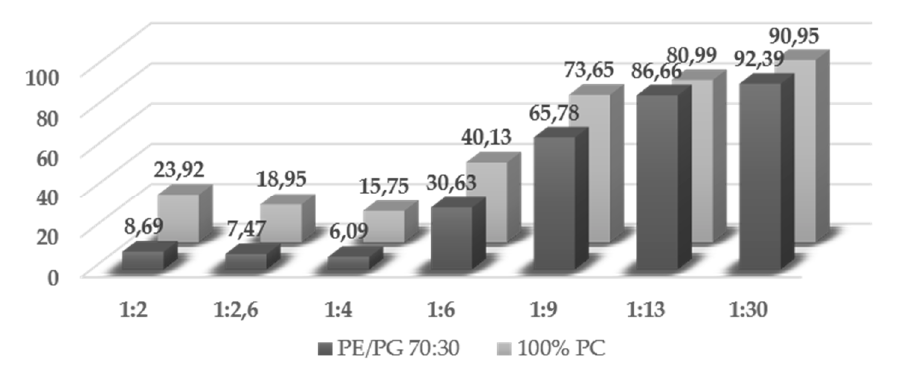
Figure 5. α -helix percentages obtained via the K2D3 algorithm using spectra obtained as explained